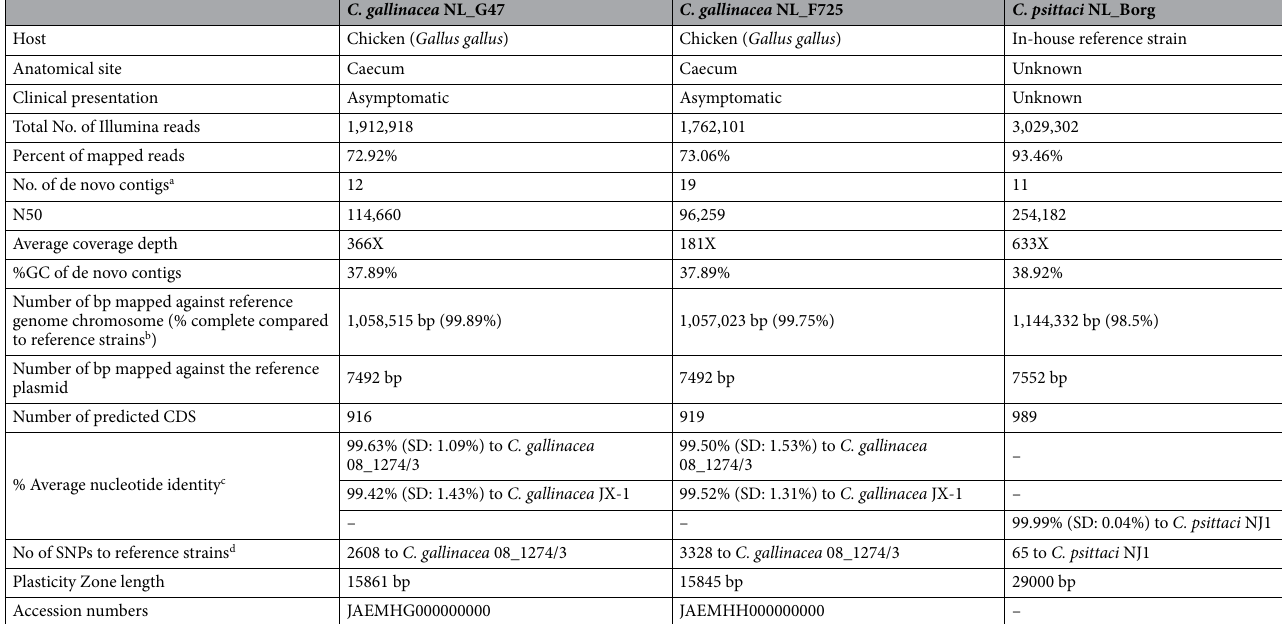
Table 1. Genome descriptions of C. gallinacea NL_G47, C. gallinacea NL_F725 and C. psittaci NL_Borg. a de novo chlamydial contigs. b Quast analyses using Short read assemblies where NL_G47 and NL_F725 were compared to 08_1274/3, and NL_Borg with NJ1. c Average nucleotide identity (ANI) determination was performed at enve-omics.ce.gatech.edu/ani/ (Goris et al. 42 ) using both best hits (one-way ANI) and reciprocal best hits (two-way ANI) between two genomic datasets with C. gallinacea 08_1274/3, C. gallinaceae JX-1 or C. psittaci NJ1 as the reference genome. d SNPs identified using Snippy v4.6.0.